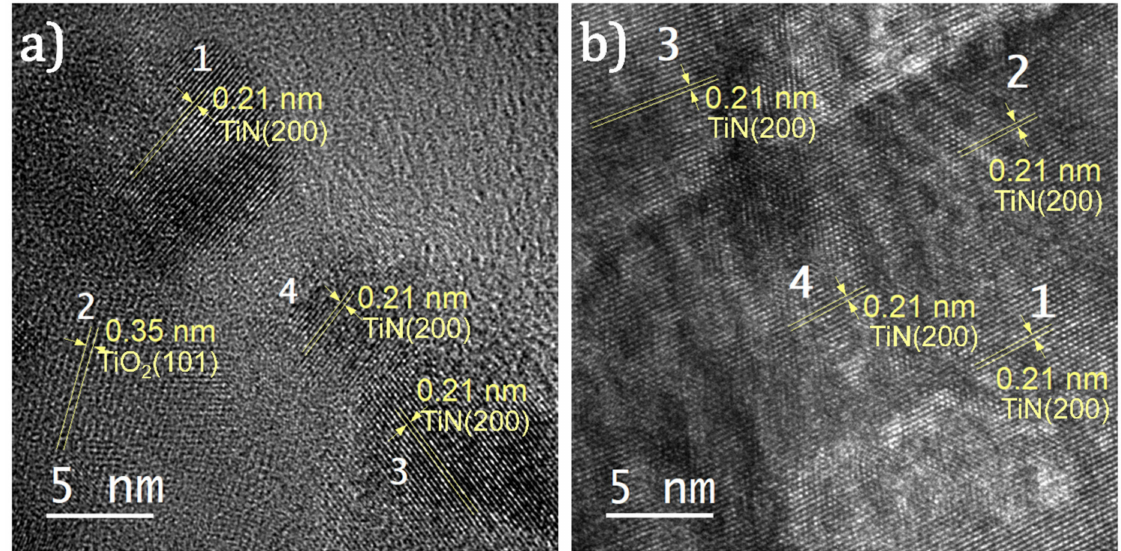
Figure 2. HR-TEM images of ( a ) TiON and ( b ) TiN. The lattice spacing was measured using Gatan Micrograph Suite ® software. The measured lattice spacing of 0.21 nm corresponds to the spacing between (200) planes of TiN, whereas the lattice spacing of 0.35 nm corresponds to the spacing between the (101) planes of anatase TiO 2